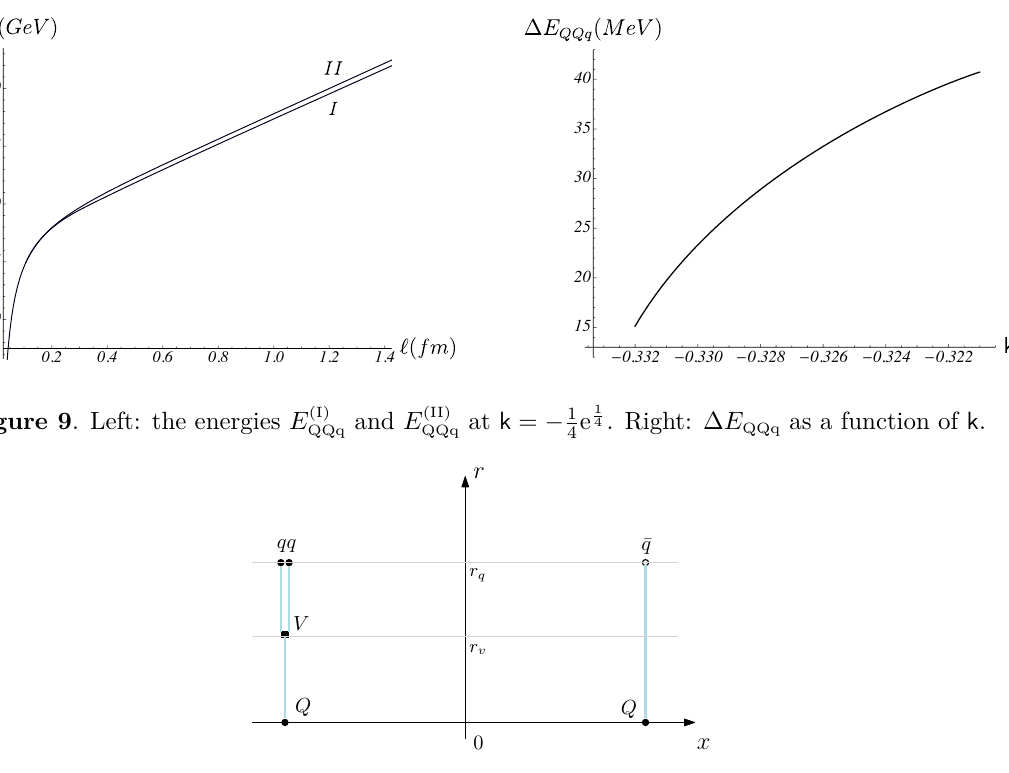
Figure 10 . A disconnected static configuration. At zero baryon chemical potential, the light antiquark ¯ q is also at r = r q